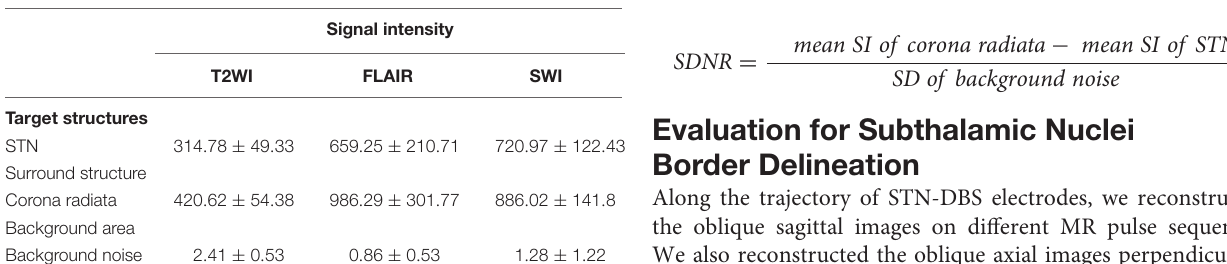
TABLE 2 | Signal intensity measurements for regions of interest (ROI) locations in 45 patients with medication-refractory Parkinson’s disease.